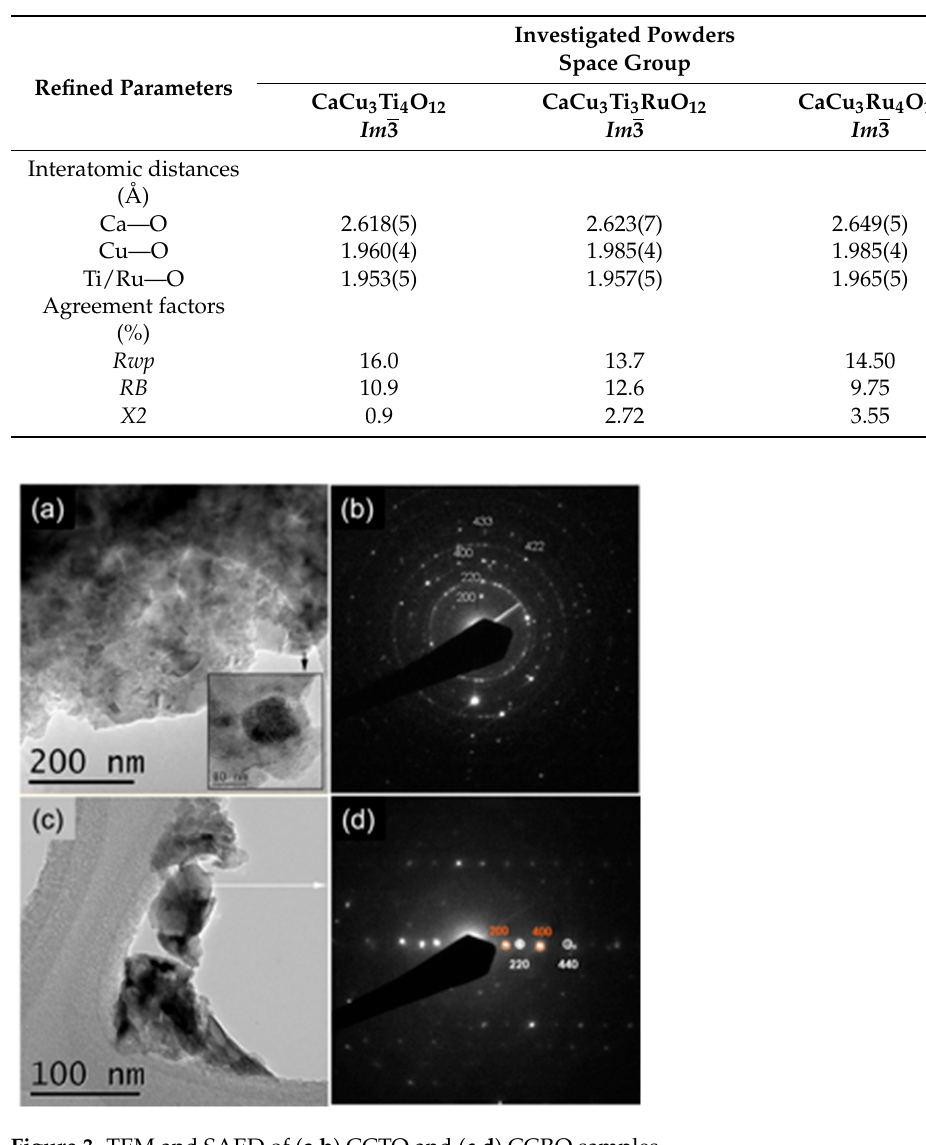
Figure 3. TEM and SAED of ( a , b ) CCTO and ( c , d ) CCRO samples. The TEM, HRTEM, and FFT analysis of the CCT3RO sample presented in Figure 4 confirm the cubic crystal symmetry with the Im 3 space group. Crystallite viewed in the [ − 111] zone axis as well as two sets of crystallographic planes (400) and (220) with interplanar distances of 1.8 and 2.6 Å, respectively, agree with a literature data for cubic CaCu 3 Ti 4 O 12 (JCPDS 75-2188). High-angle annular dark-field STEM and corresponding EDXS elemental mapping presented in Figure 5 implies the homogeneous distribution of Ca, Cu, Ti, Ru and O in CCT3RO particles, independently of their